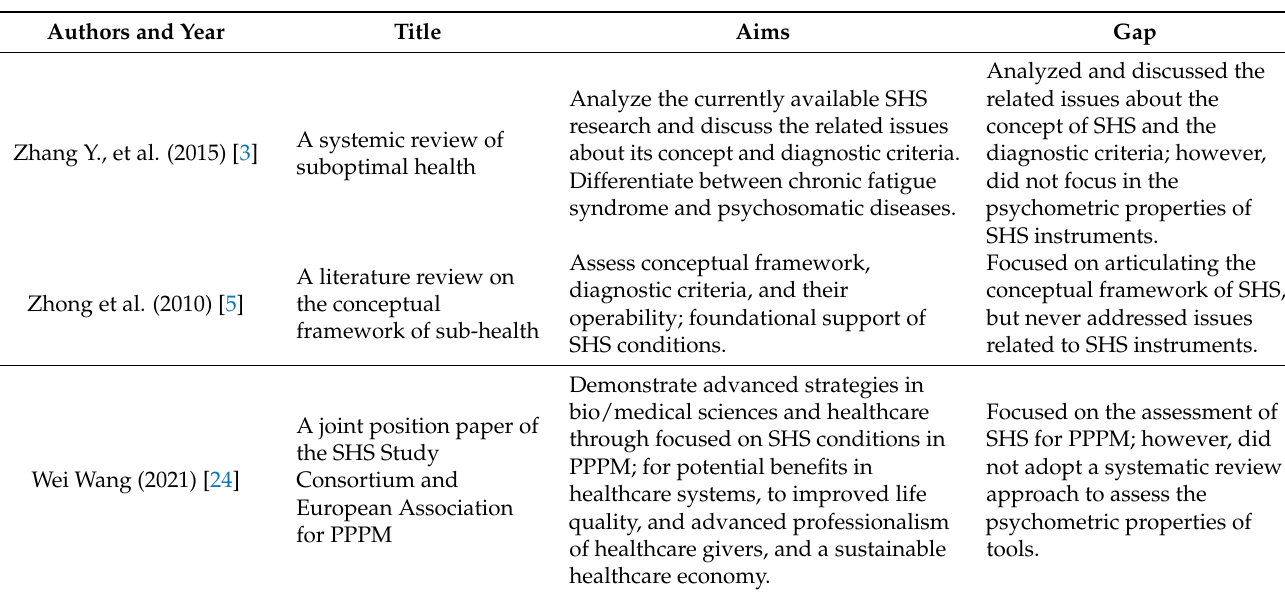
Table 1. Current gaps in previous systematic reviews on